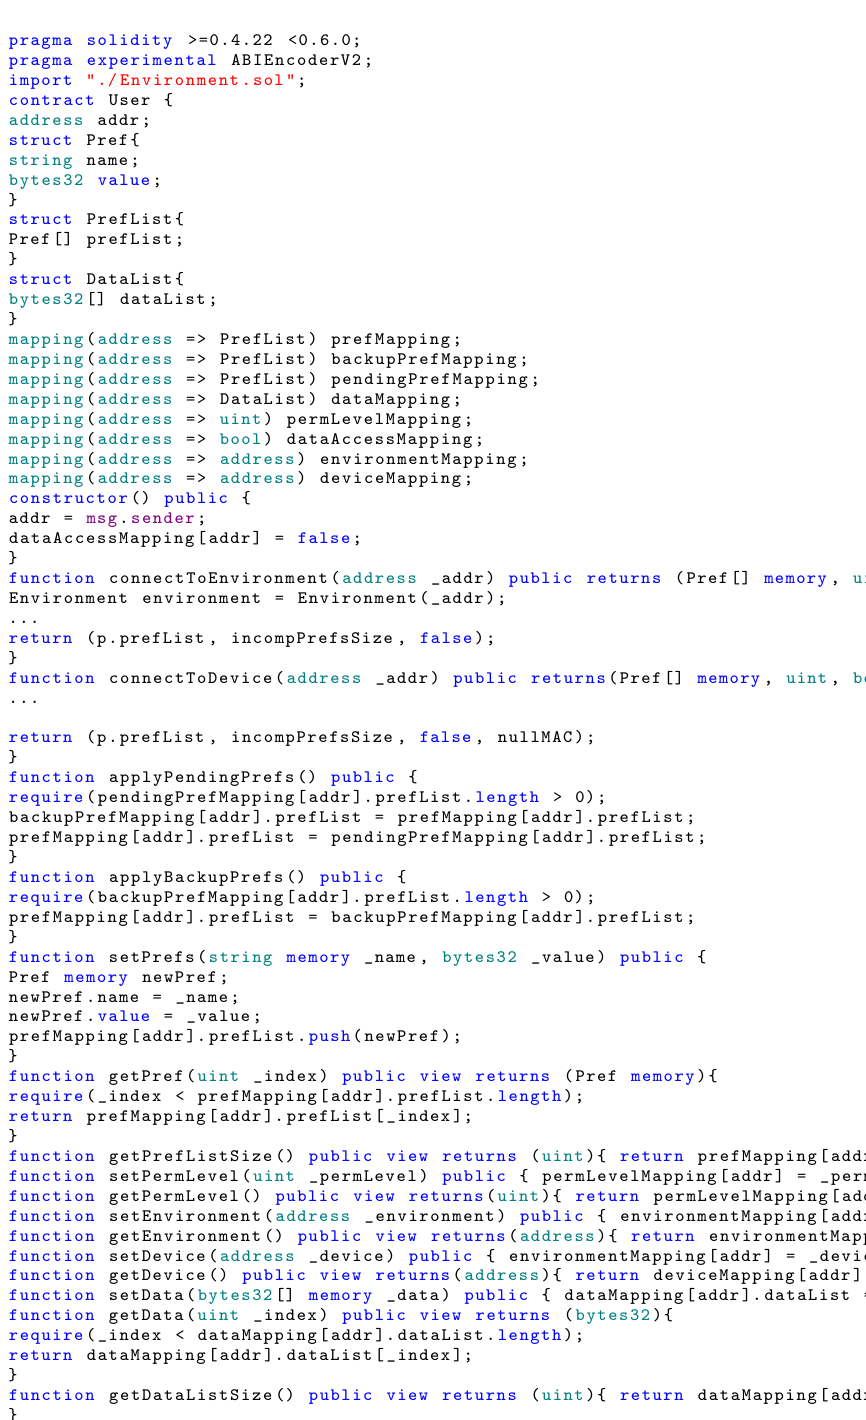
Figure A2. User Smart